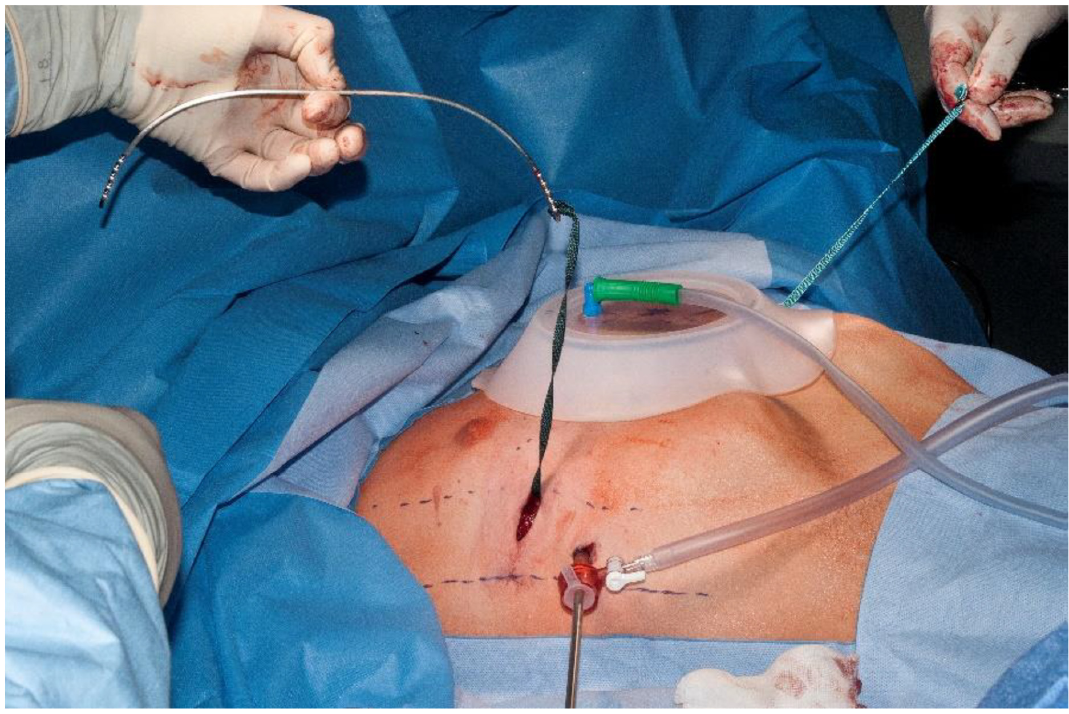
Figure 3. Intraoperative application of the vacuum